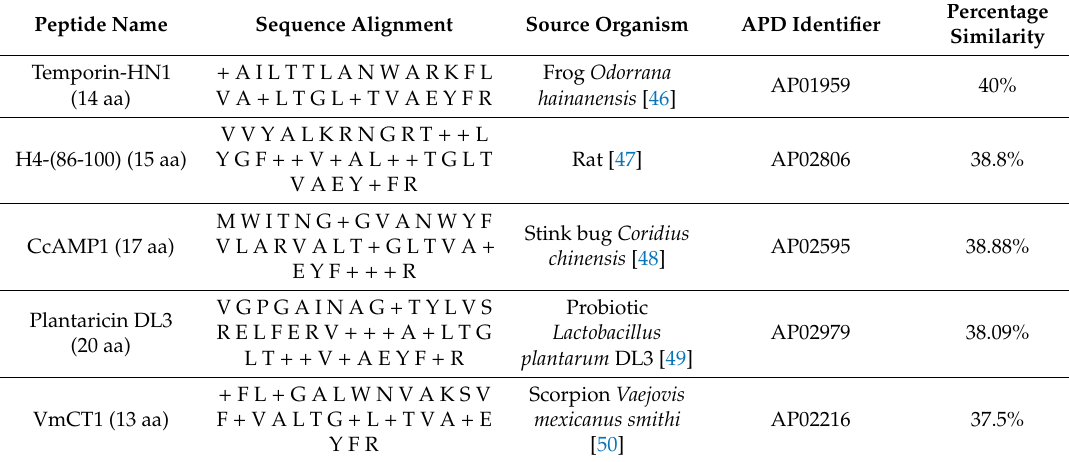
Table 3. Known antimicrobial peptides having similarity with sarconesin II, as identified in the Antimicrobial Peptide Database (APD2) (Wang et al.,